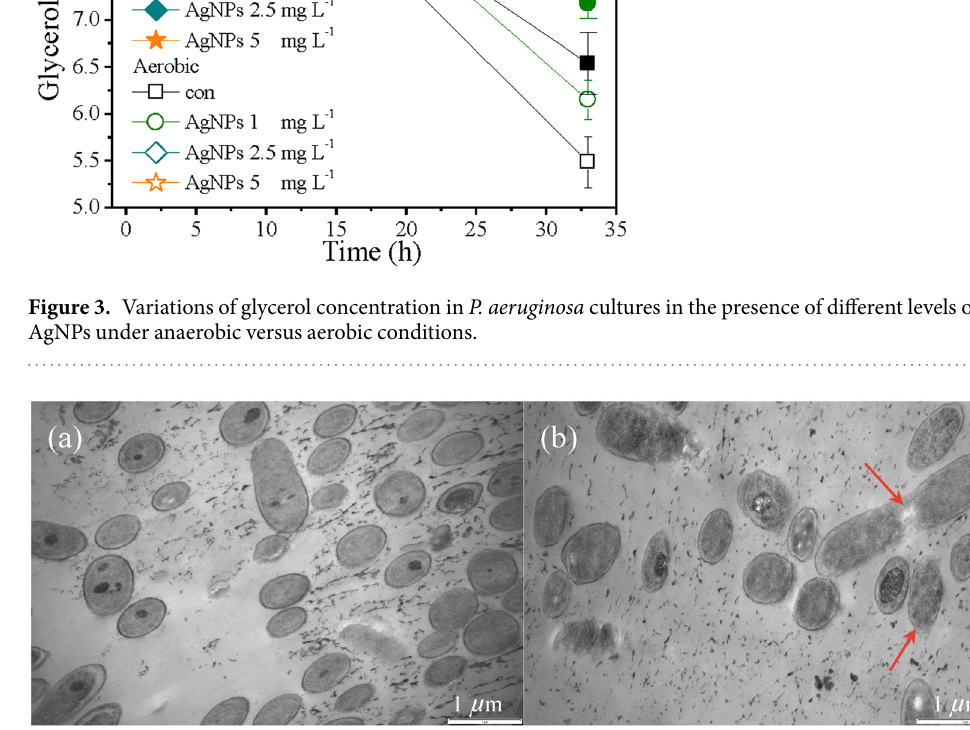
Figure 4. Representative transmission electronic microscopy images of P. aeruginosa under 6 h exposure in the absence ( a ) and presence ( b ) of AgNPs (2.5 mg L -1 ). Arrows point to cells with damage membrane or